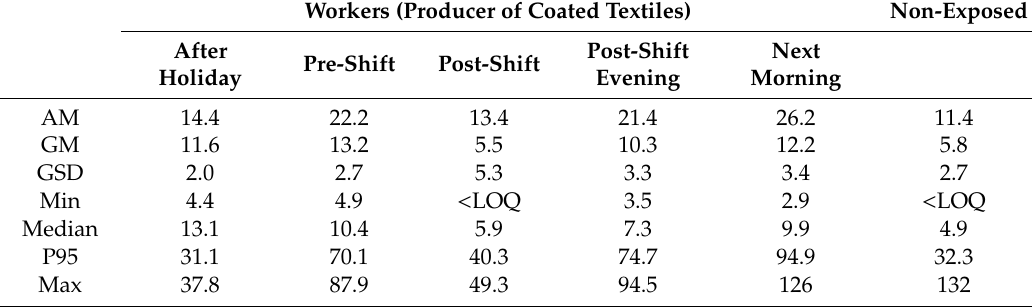
Table 4. Total urinary cx-MiOP concentrations of workers in the company producing coated textiles ( n = 8) by sampling time. First-morning-void concentrations of occupationally non-exposed control population ( n = 60) are provided for comparison [9]. Concentrations ( µ g / L) were normalized to a specific gravity of 1.021. Workers (Producer of Coated Textiles) Non-Exposed After